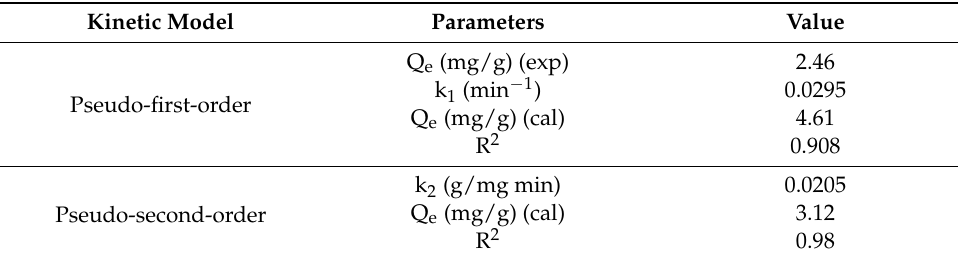
Figure 8. ( a ) Pseudo-first-order kinetic plot. ( b ) Pseudo-second-order kinetic plot. Table 1. Kinetic parameters calculated for the biosorption of RBV-5R on SCB. Kinetic Model Parameters